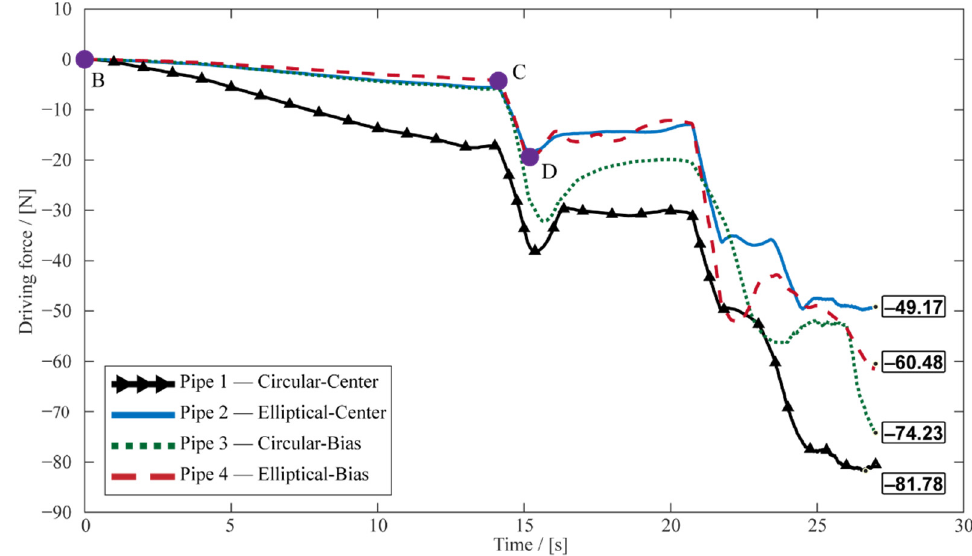
Figure 24. Results of driving forces by simulation: ( X − 2 mm, Z − 2 mm, Roll − 1°, Yaw − 1°, Pitch − 1°). The maximal driving forces (listed from pipe 1 to pipe 4) are 49.17 N, − 60.48 N, − 74.23 N, and − 81.78 N. (The definitions of the points B, C and D can be found in Figure 22.)